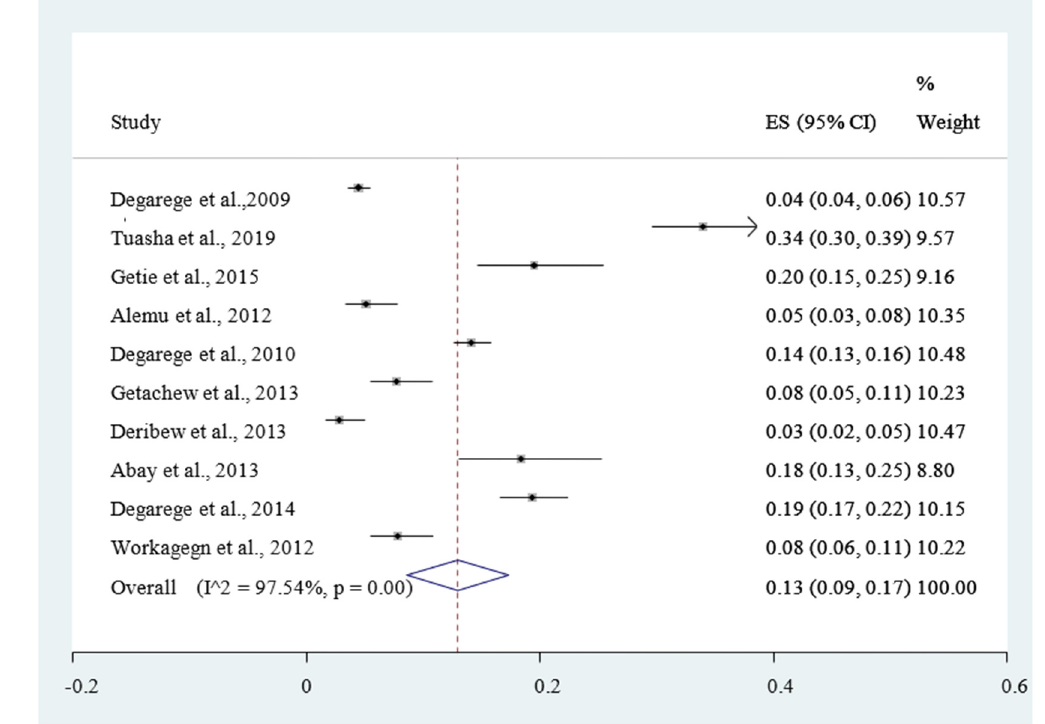
Figure 2. Forest plot of the pooled estimate of the comorbidity of geo-helminths and malaria among outpatients in Ethiopia, 2020.